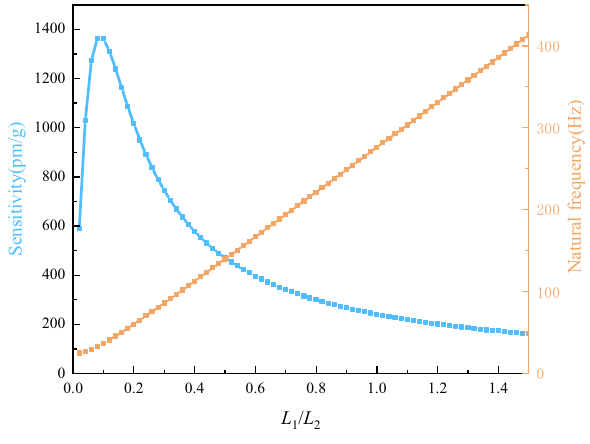
Figure 4. Effect of L 1 / L 2 on S and f .